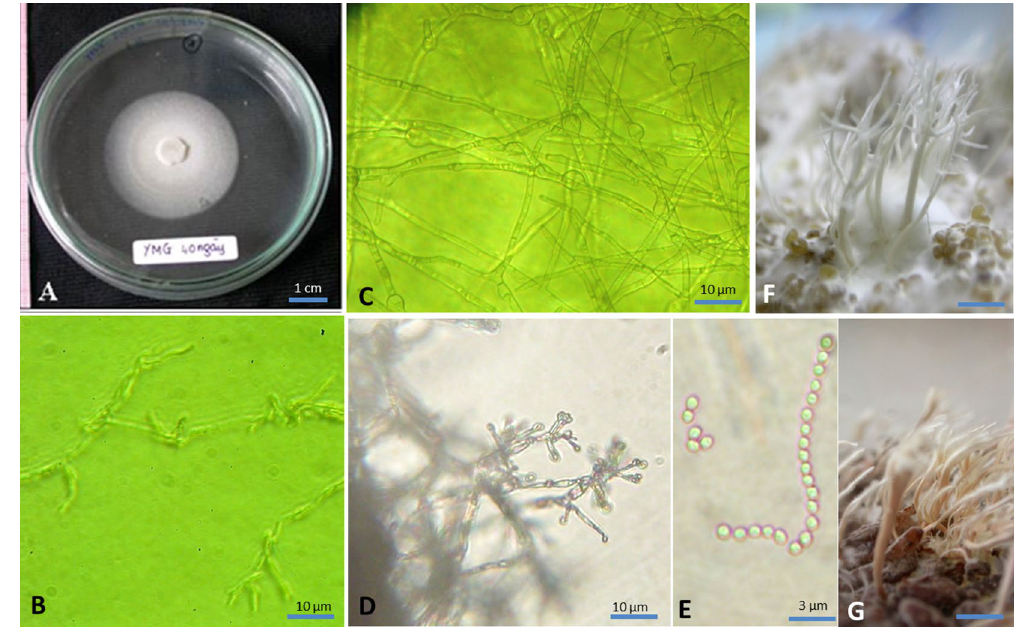
Figure 3. Asexual states. ( A ) Ascospores germinating after 96 h; ( B ) Septate hyphae, branched, conidia in intercalary or terminal cells; ( C ) White colony after 45 days on YMG media; ( D ) Aerial hyphae with divergent phialides; ( E ) Elliptical conidia in chains after release from the phialide, ( F , G ) Stromata growing on cereal